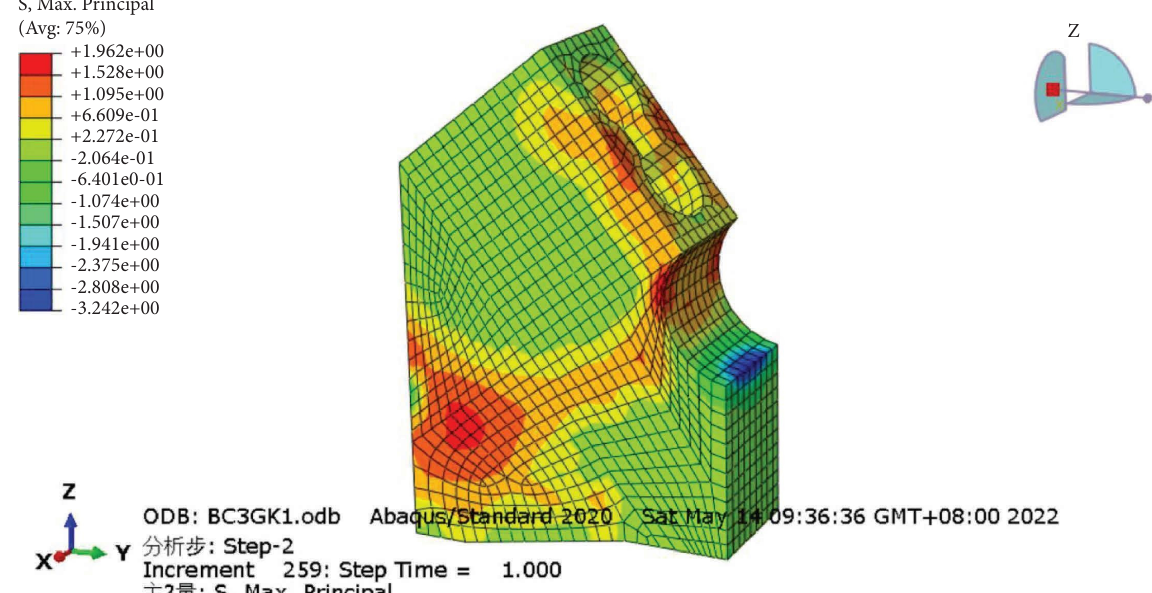
Figure 5: Cloud chart of the principal tensile stress of the arch foot without anchorage of condition 10.